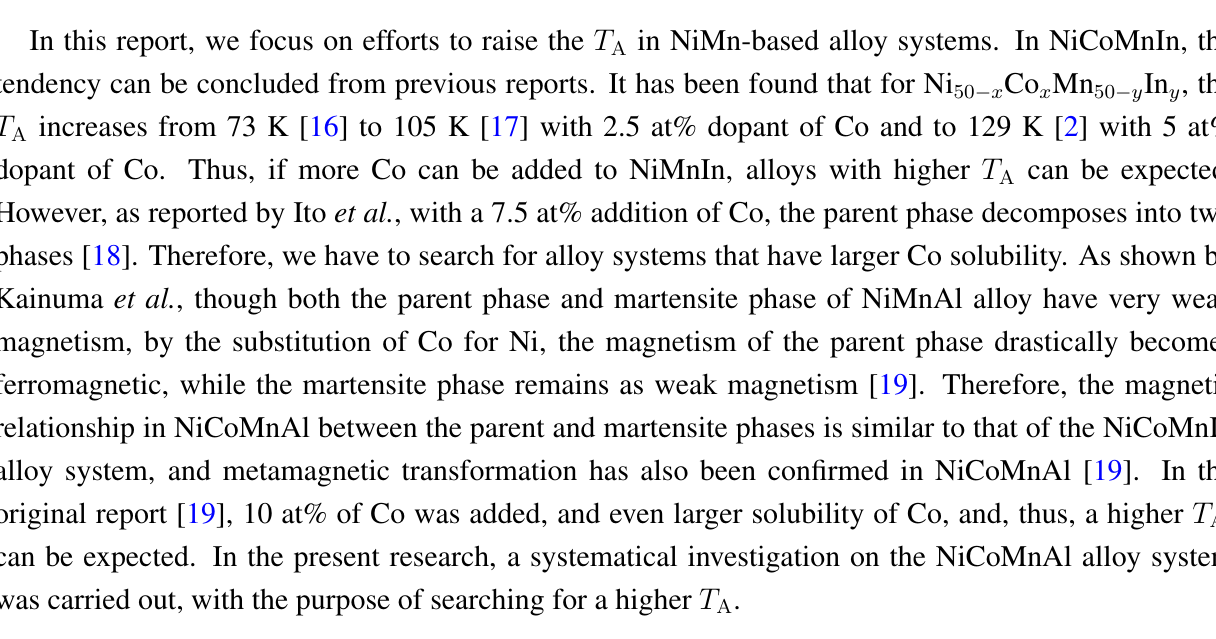
Table 1. Compositions of Ni percentage. Data of the Curie temperature ( T temperature ( T